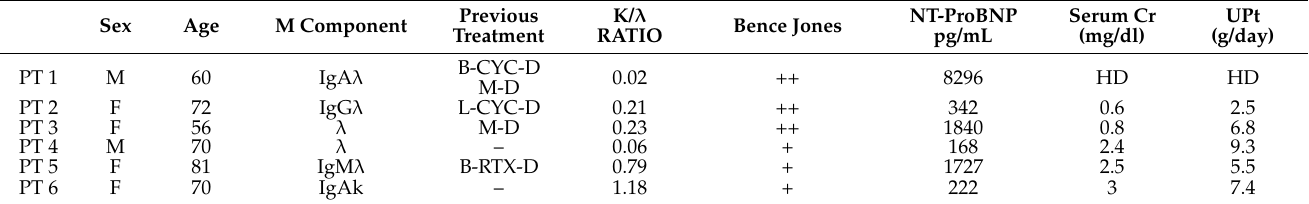
Table 1. Demographic and clinical characteristics of patients at